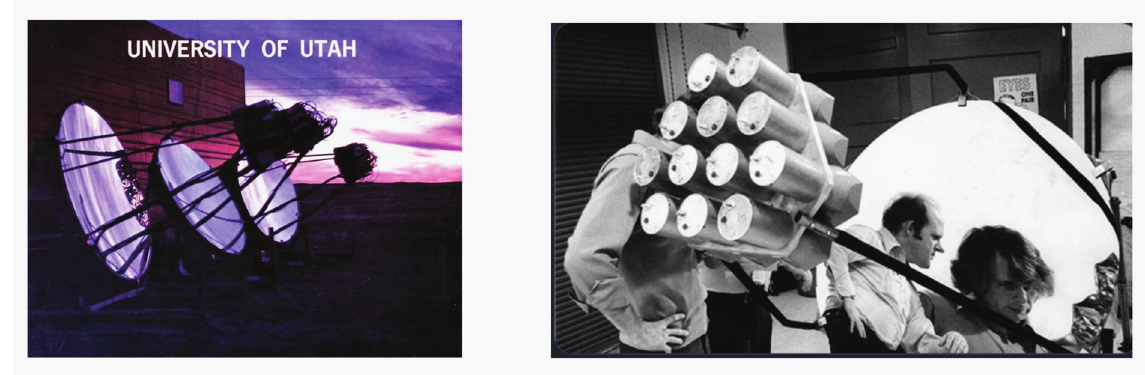
Figure 3. Utah air-fluorescence prototype detector. H. Bergeson (L) and G. Cassiday (R) reflected in